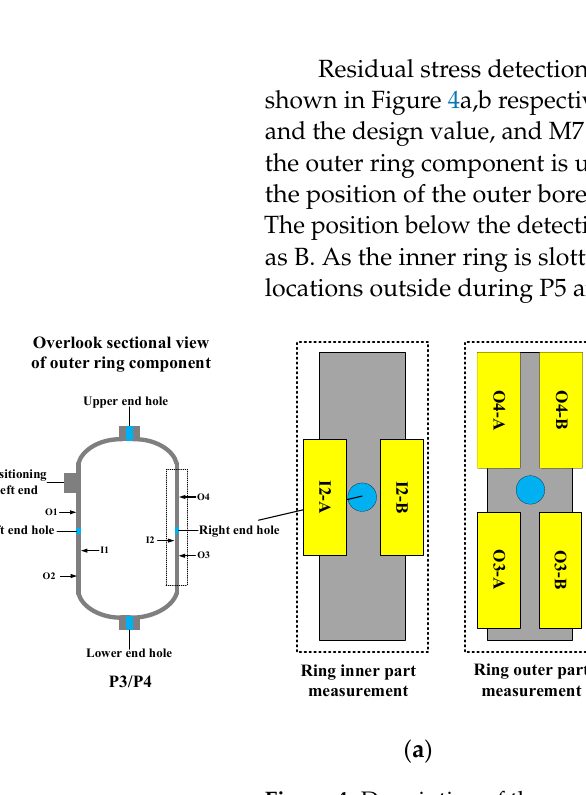
Figure 4. Description of three coordinate measuring position g: ( a ) Schematic diagram of residual stress detection point; ( b ) Description of three coordinate measuring position: M1 is distance between left and right end of inner part, M2 is distance between upper and lower end of inner part, M3 is Inner part radius of lower end, M4 is Outer part radius of lower end, M5 is Inner part radius of upper end, M6 is Outer part radius of upper end, and M7 is Verticality of connection between upper–lower holes and left–right holes.